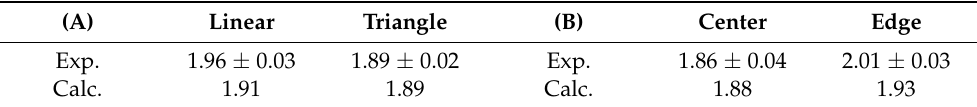
Table 1. Average charge of fragment ions for the 1 MeV/atom C 3 + cluster ion, penetrating a carbon foil of 2.4 µ g/cm 2 thickness. (A) structure dependence, (B) atom position dependence in a linear chain structure [16].